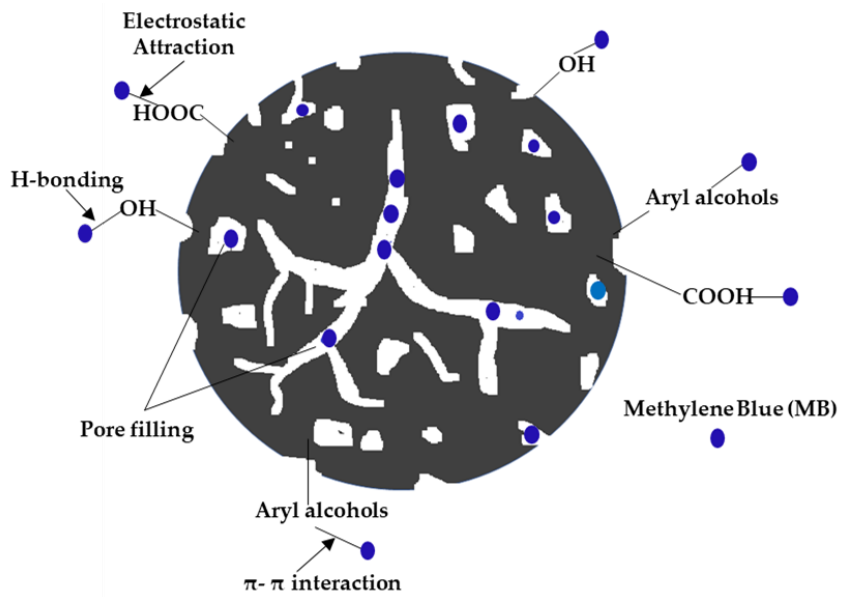
Figure 7. The adsorption mechanism of MB dyes onto BGS-derived biochar.